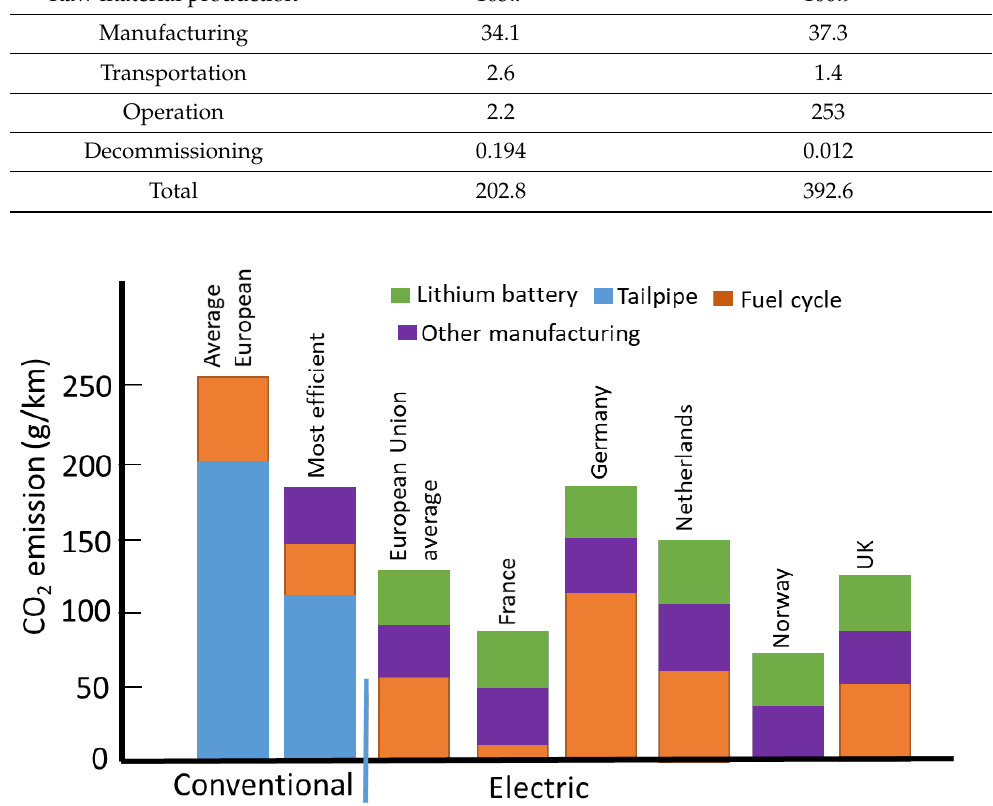
Figure 2. Life cycle emission of electric and conventional vehicles in Europe (2015) with a mileage of 150,000 km [Redrawn from Ref. [76], open access].